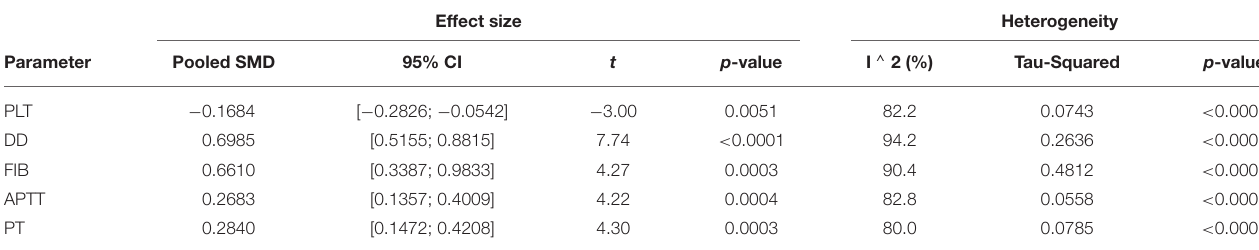
TABLE 1 | Summary of the effect sizes for all coagulation parameters.